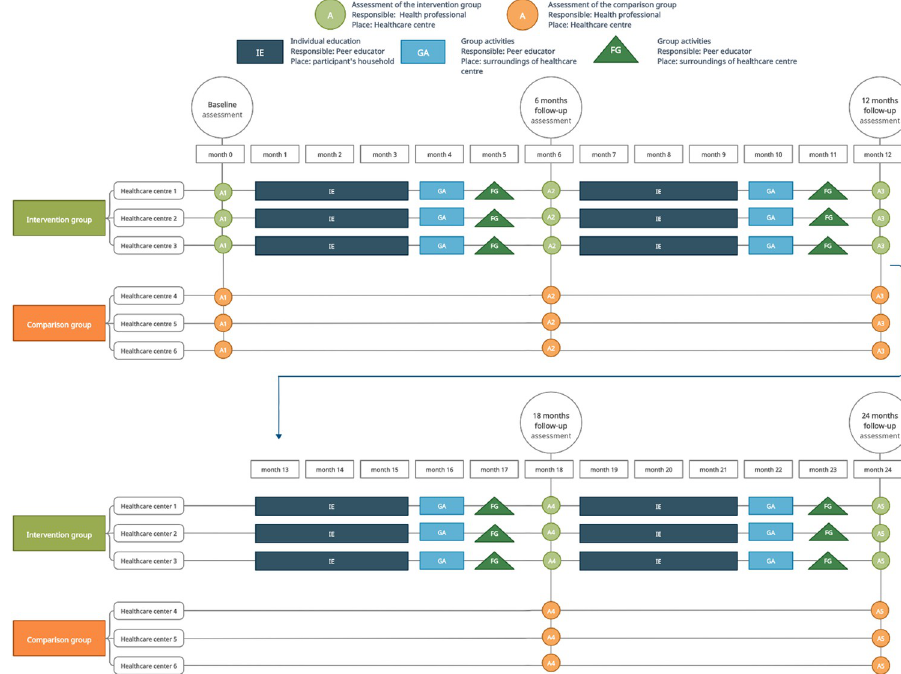
Fig 3. Timeline of the multi-component health promotion